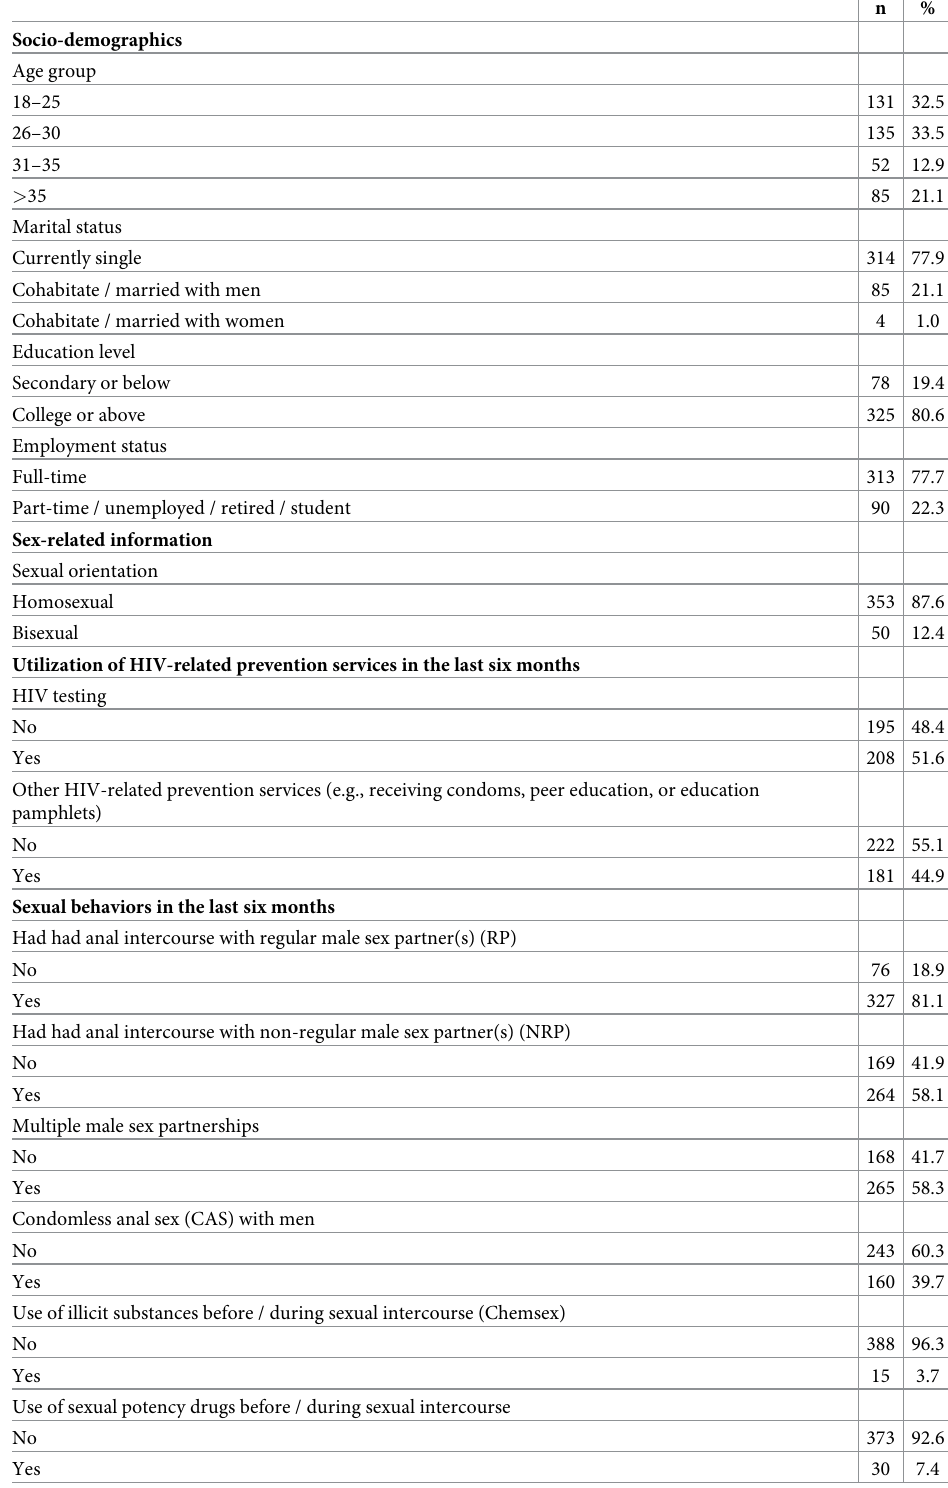
Table 1. Background characteristics of men who have sex with men (n =